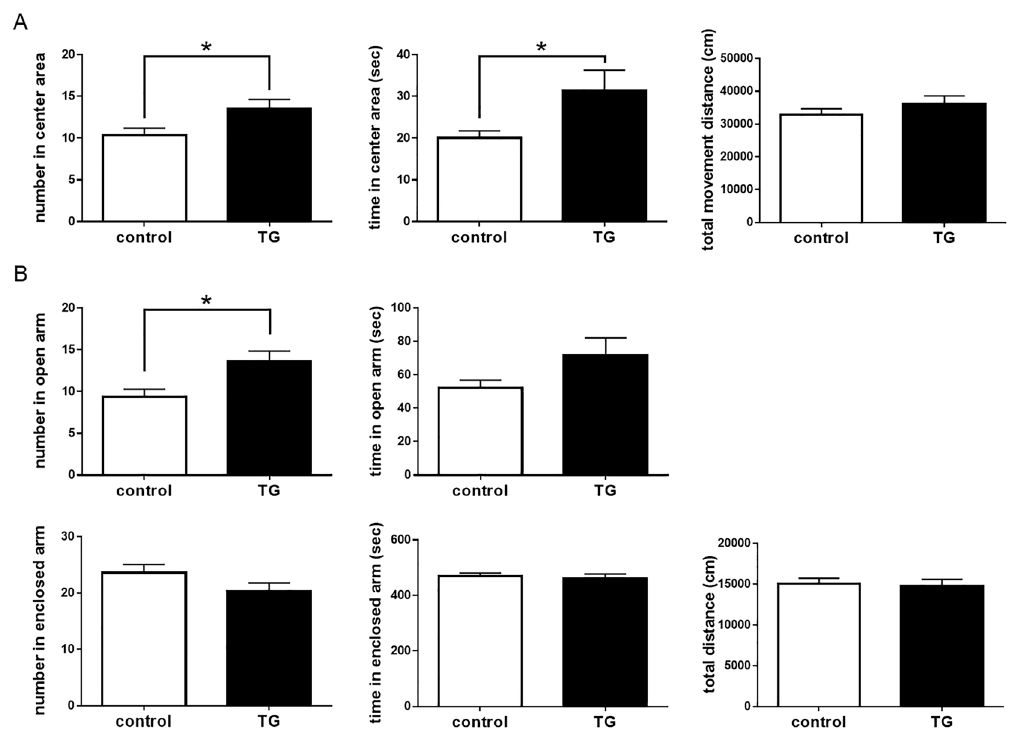
Figure 4. Behavioral performance in transgenic (TG) mice. ( A ) In the open field (OF) test, total number of entries in the center of the OF was significantly different between C57BL/6 control and TG mice. Each bar represents mean ± SEM of C57BL/6 control mice ( n = 13) or TG mice ( n = 13); * p < 0.05, Student’s t -test; ( B ) In the elevated-plus maze (EPM) test, total number of entries and total time in open arms were significantly different between the two groups of mice. Each bar represents mean ± SEM of C57BL/6 control mice ( n = 13) or TG mice ( n = 13); * p < 0.05, Student’s t -test.